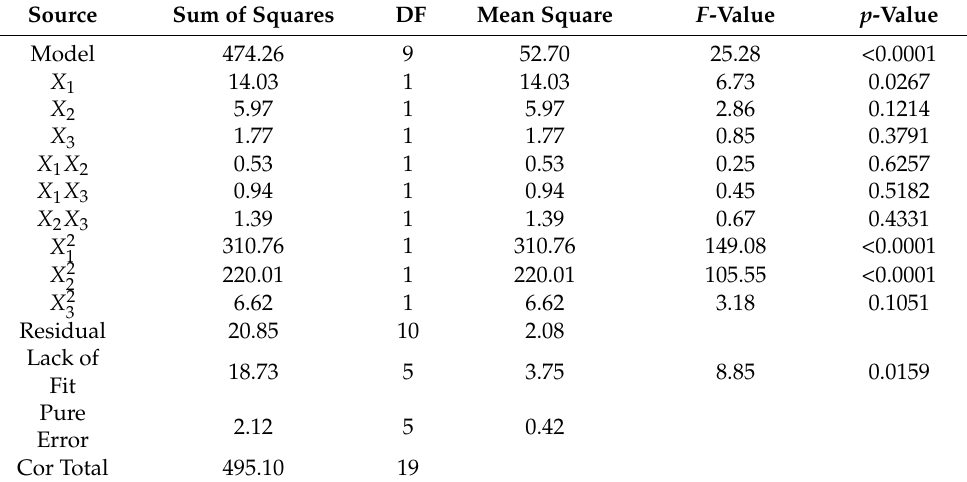
Pure Error Cor Total Table 3. Analysis of variance (ANOVA) for the response surface model. Source Sum of Squares DF Mean Square F -Value Model